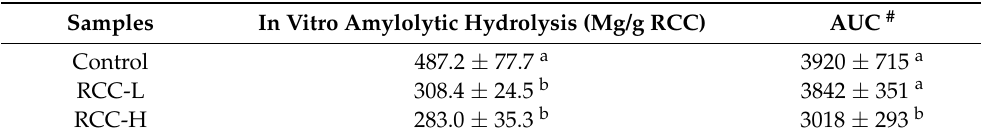
Table 3. In vitro and In vivo starch digestibility of different rice samples.